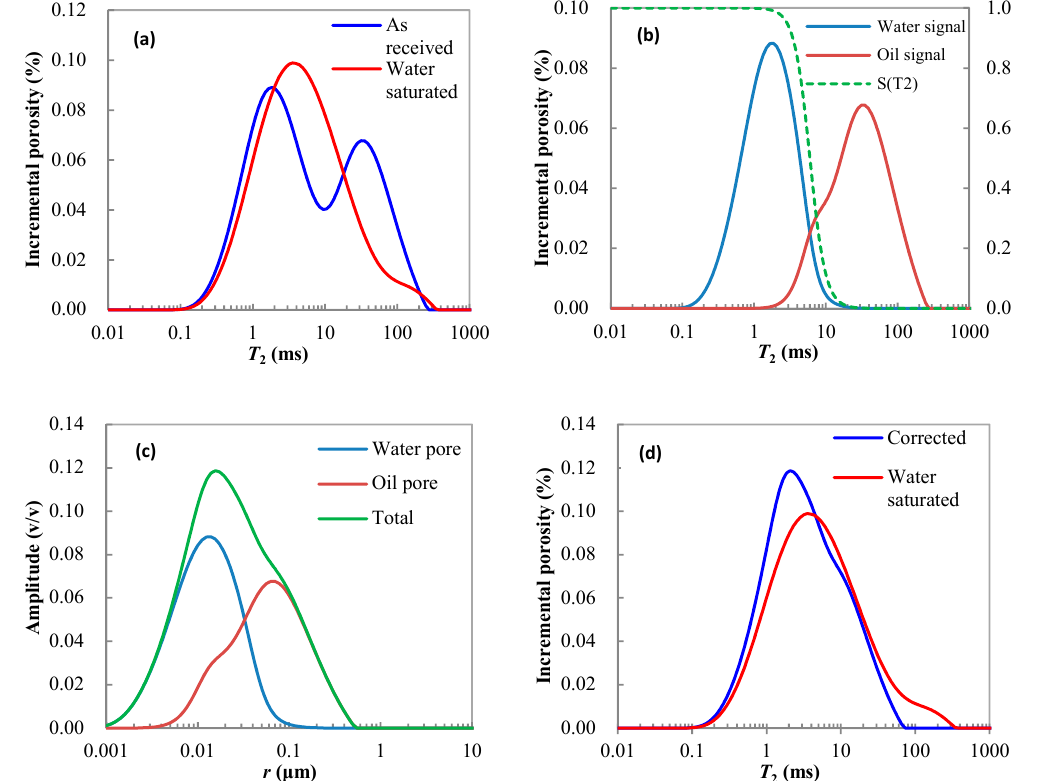
Figure 7. Sample M1: ( a ) T 2 distributions for “as received” state and water saturated state; ( b ) Water and oil signal distributions obtained from “as received” state T 2 distribution using weight function S ( T 2 ); ( c ) Water-containing pore, oil-bearing pore and total pore size distributions; ( d ) Comparison of corrected and measured T 2 distributions for water-saturated state.